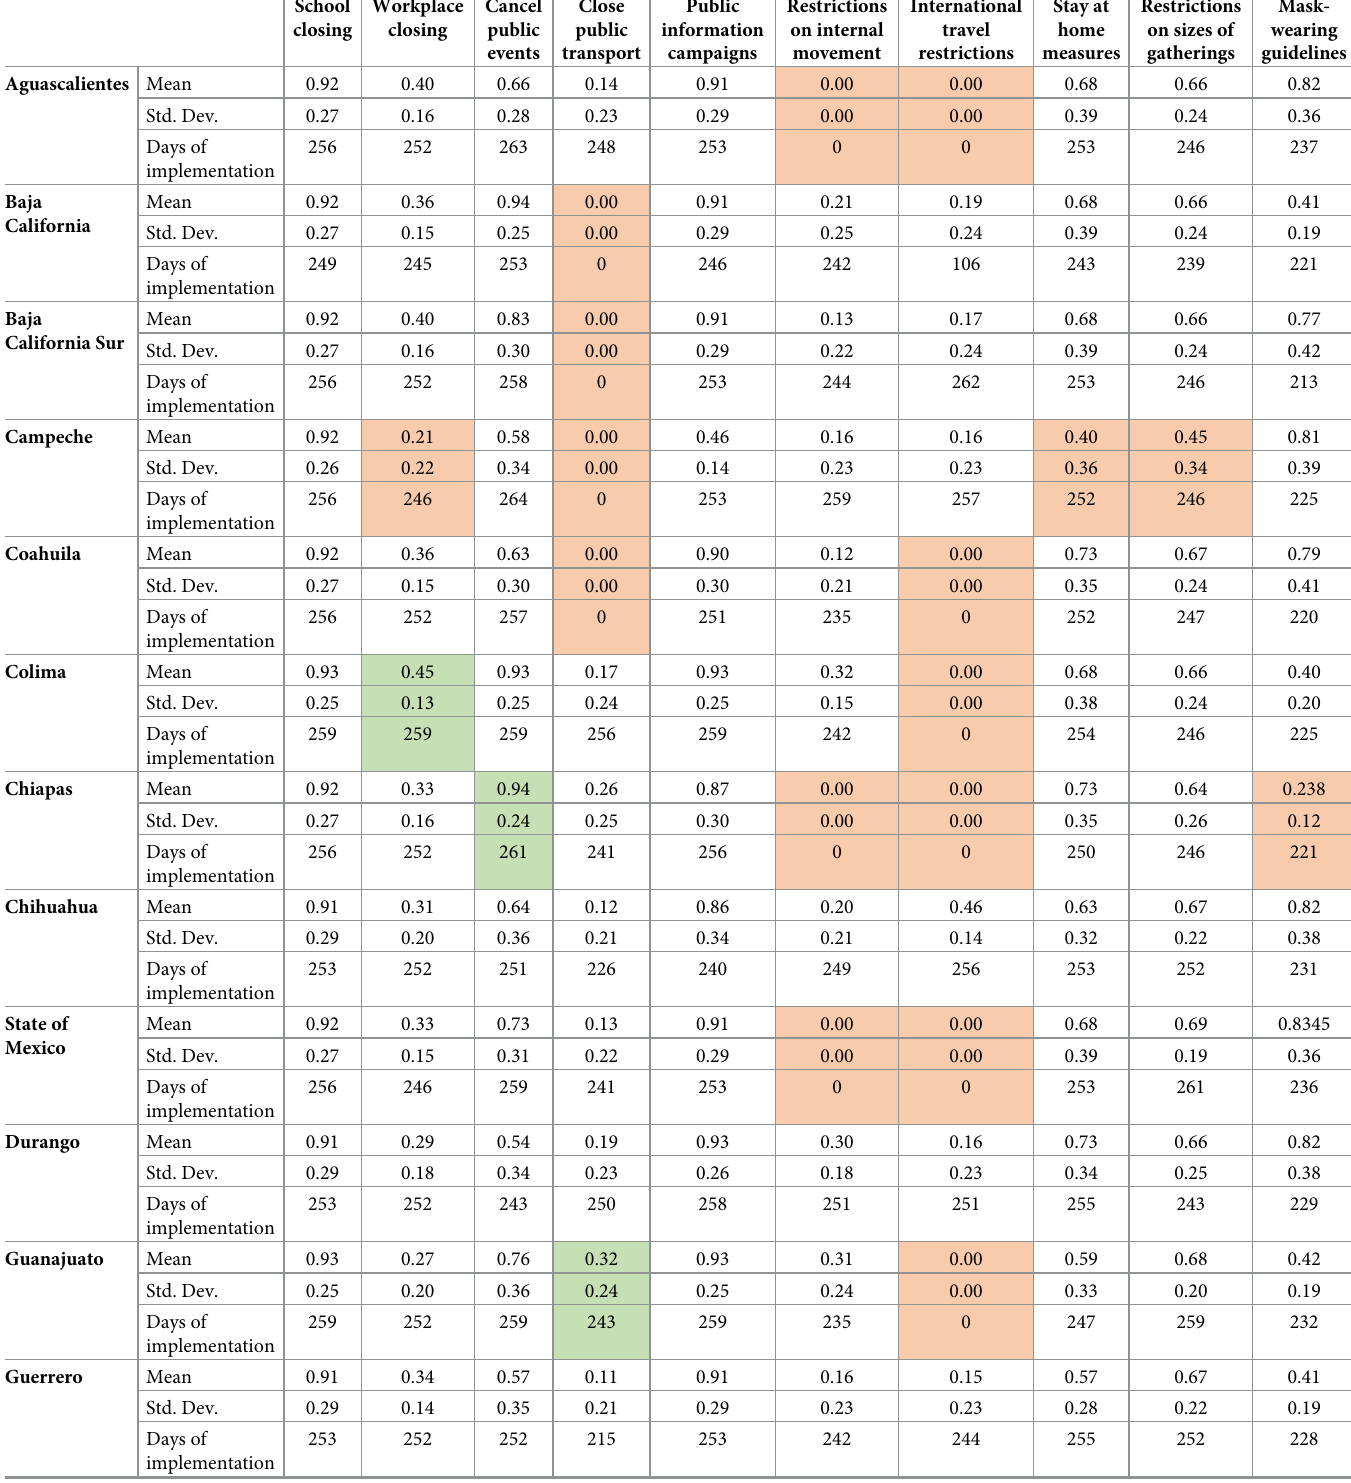
Table 3. Descriptive statistics of the 10 public policy variables by state. From February 27 to November 30, 2020.